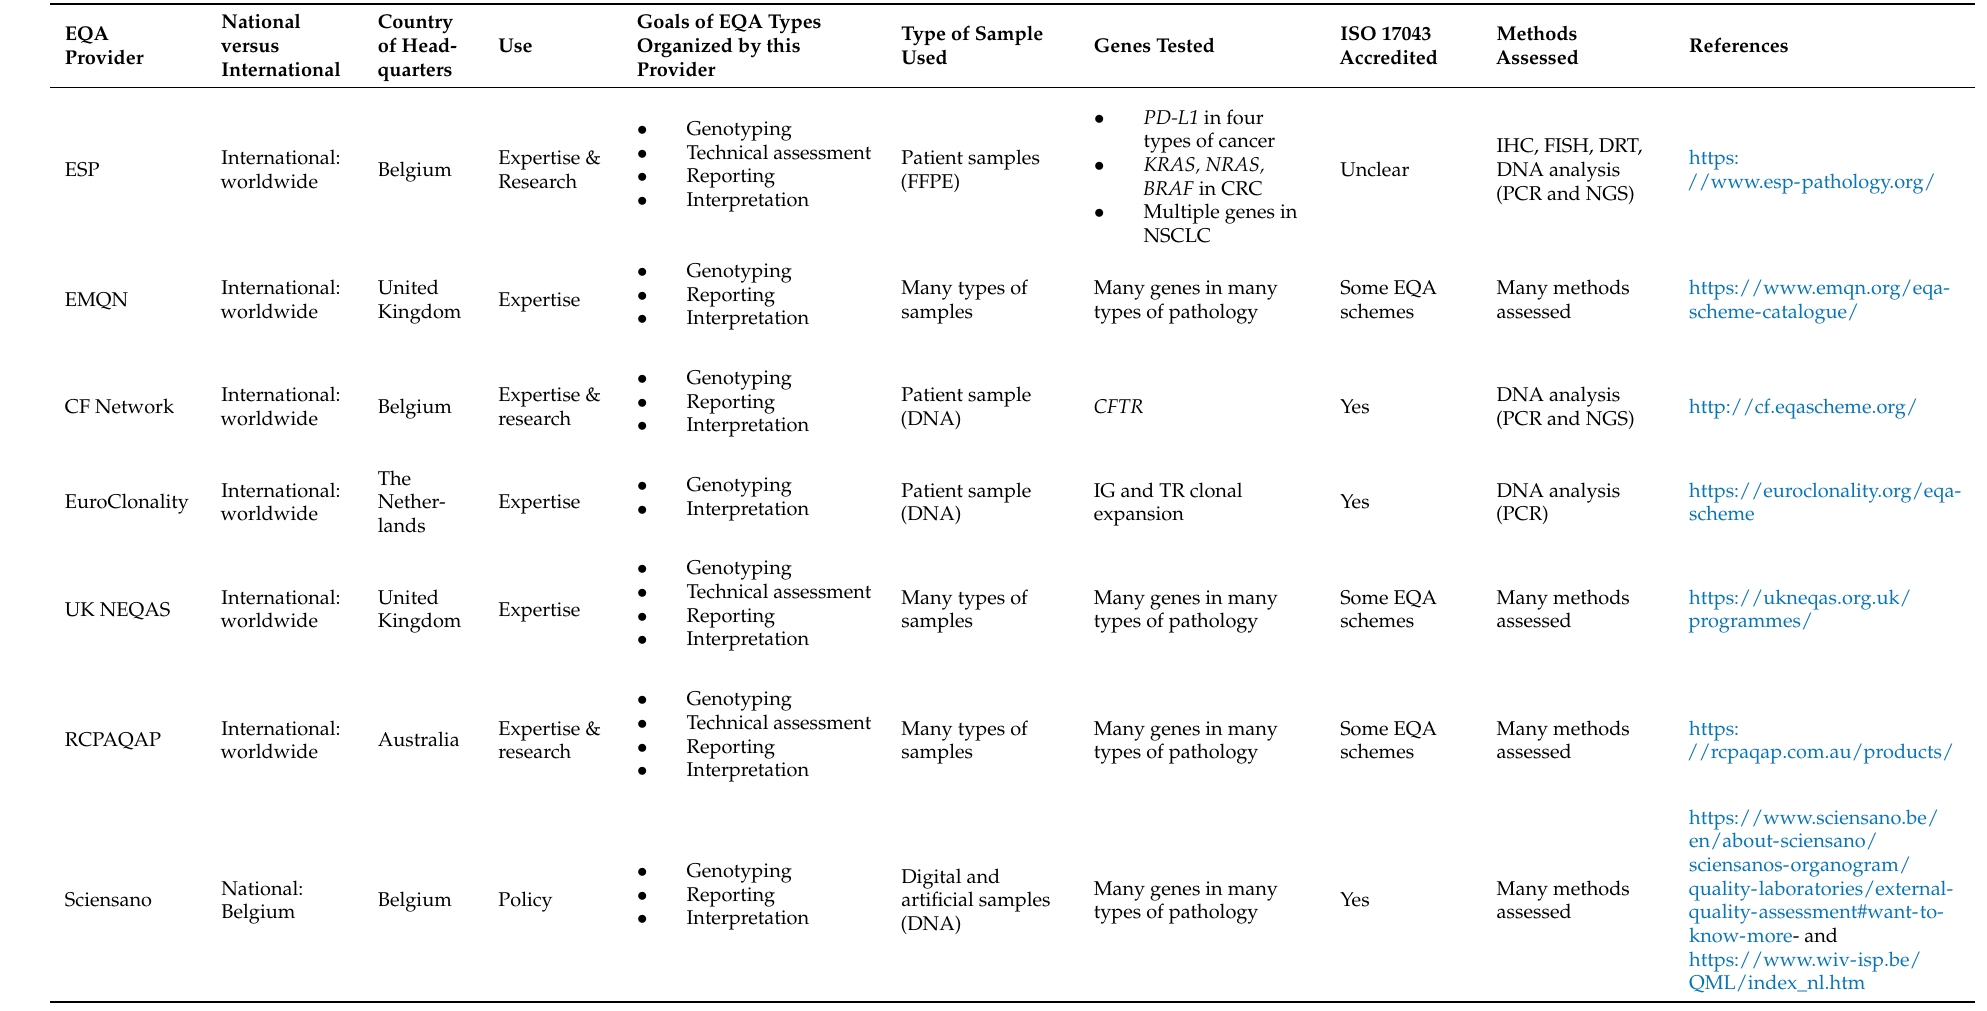
Table 1. Overview of types of EQA providers and their characteristics (situation in 2021). This table serves as an example and is not an exhaustive